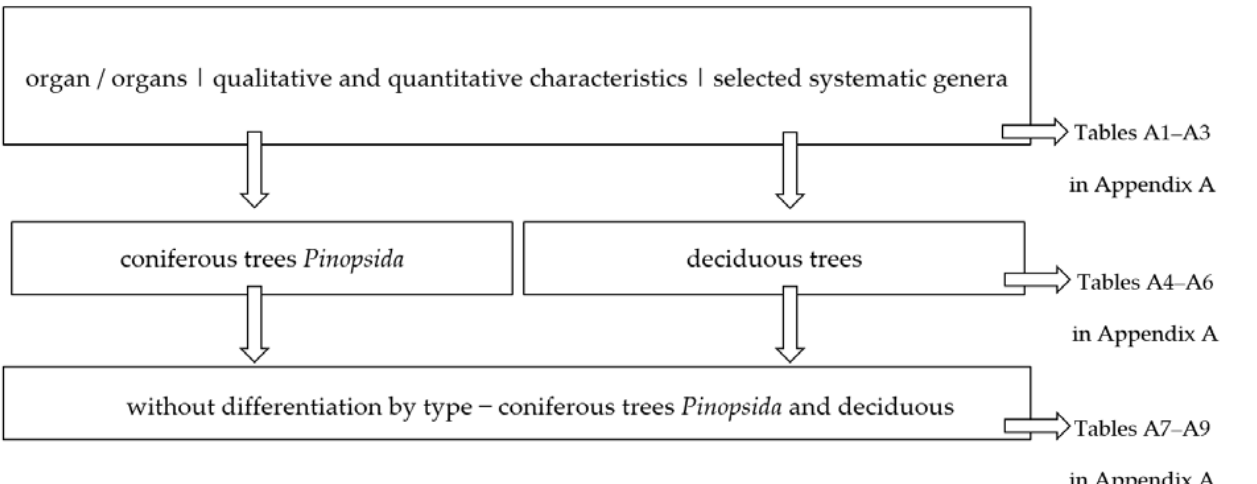
Figure 1. The procedure in data listing and the content of Tables A1–A9 in Appendix A based on